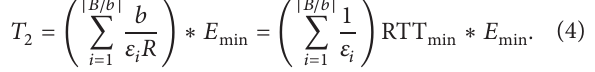
change of links is random and the maximum transmission rate of links is R , so the transmission rate of each packet is 𝜀 𝑖 𝑅 ( 𝜀 𝑖 ∈ [0, 1] ) and the minimum ETX of this link is 𝐸 min . The time of transmission is shown as